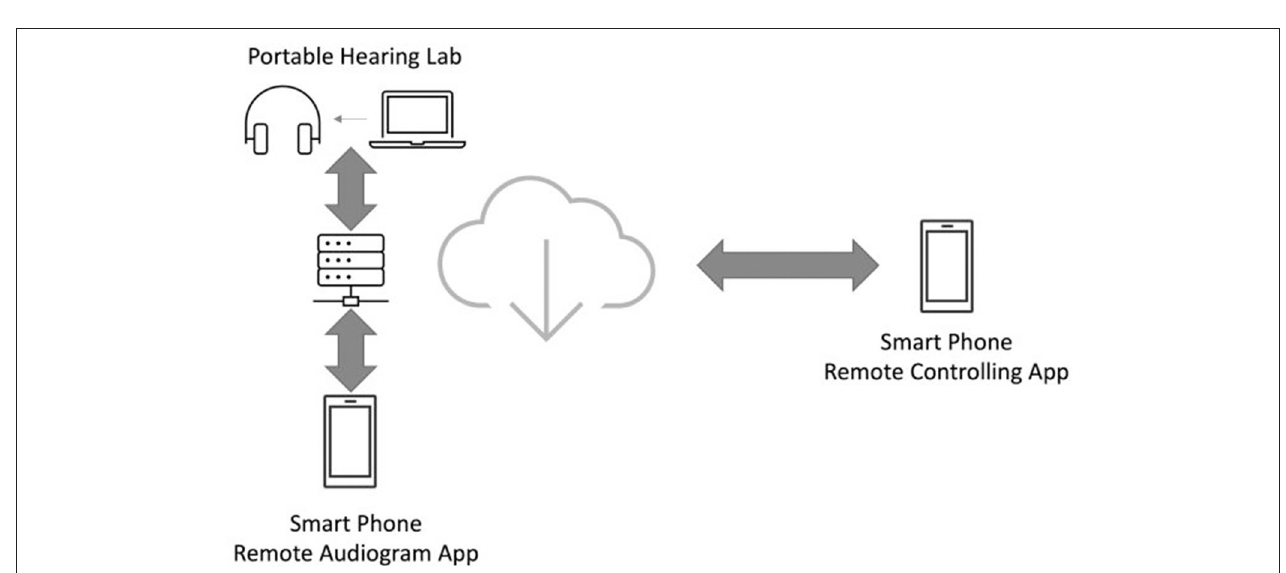
FIGURE 10 | The architecture of the remote audiogram measurement performed using the remote AudioPSS-app.